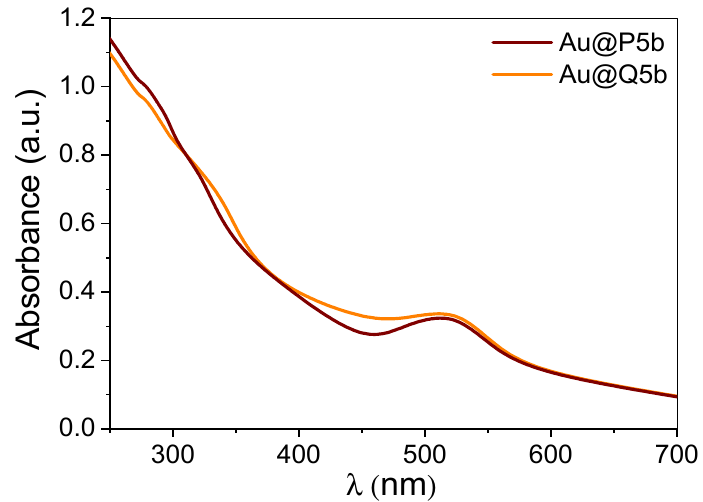
Figure 4. UV-vis spectra of gold@pentablock terpolymer hybrid nanoparticle aqueous solution of 0.2 mg/mL in PBS at pH